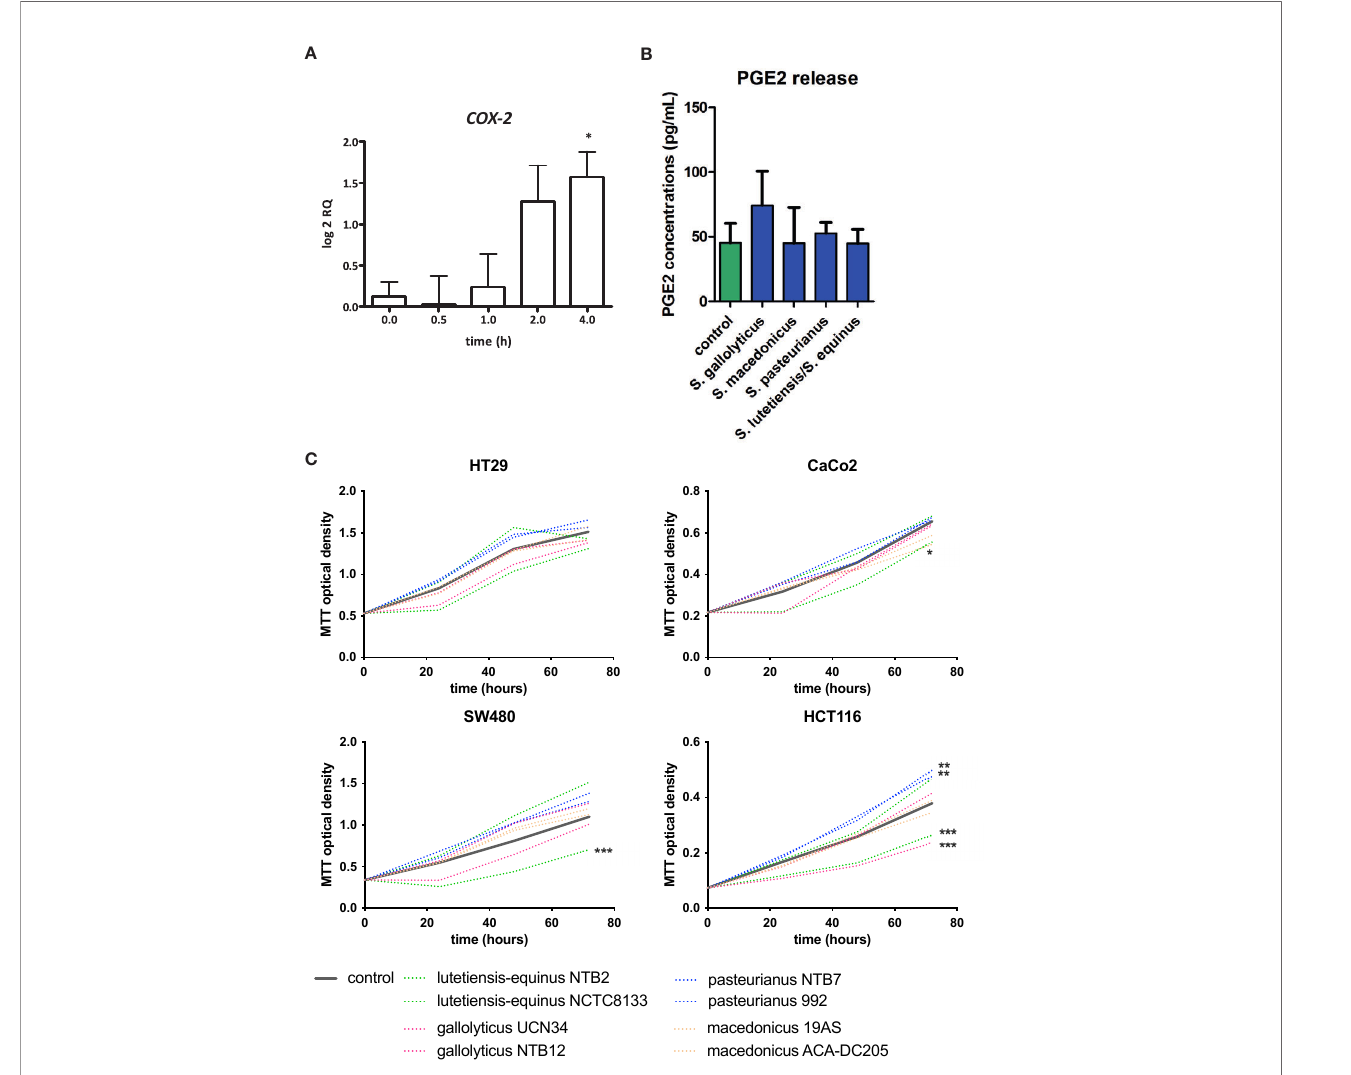
FIGURE 5 | COX-2 induction, PGE2 release, and cell proliferation by SGS. (A) Expression of COX-2 in HT29 cells was examined by qPCR after exposure of these cells to S. gallolyticus UCN34 at an MOI of 20 for 4 h COX-2 was signi fi cantly upregulated as determined by one-way ANOVA (*p < 0.05). (B) PGE2 release after exposure to secretomes of S. gallolyticus subsp. gallolyticus (UCN34/NTB12), S. gallolyticus subsp. pasteurianus (NTB7/992), S. gallolyticus subsp. macedonicus (19AS/ACA-DC-205), and S. equinus/lutetiensis (NCTC8133/NTB2). No signi fi cant increase in PGE2 release was observed after 24 h. (C) Cell growth was measured with MTT assay at 24, 48, and 72 h in HT29, Caco-2, HCT116, and SW480 cells. Each secretome condition was performed in quadruplicate. The area under the curve was calculated for each condition and compared to control cells using independent t-test. HCT116 cells were most sensitive to S. bovis group bacteria. In none of the conditions, S. gallolyticus subsp. gallolyticus secretomes induced cell growth. S. gallolyticus subsp. gallolyticus NTB12 even inhibited cell growth in HCT116 cells. Only S. gallolyticus subsp. pastereurianus strains 992 and NTB7 were able to induce cell growth in HCT116 cells. S. lutetiensis NTB2 consistently inhibited cell growth in CaCo-2, SW480, and HCT116 cells. *p < 0.05, **p < 0.01, ***p <